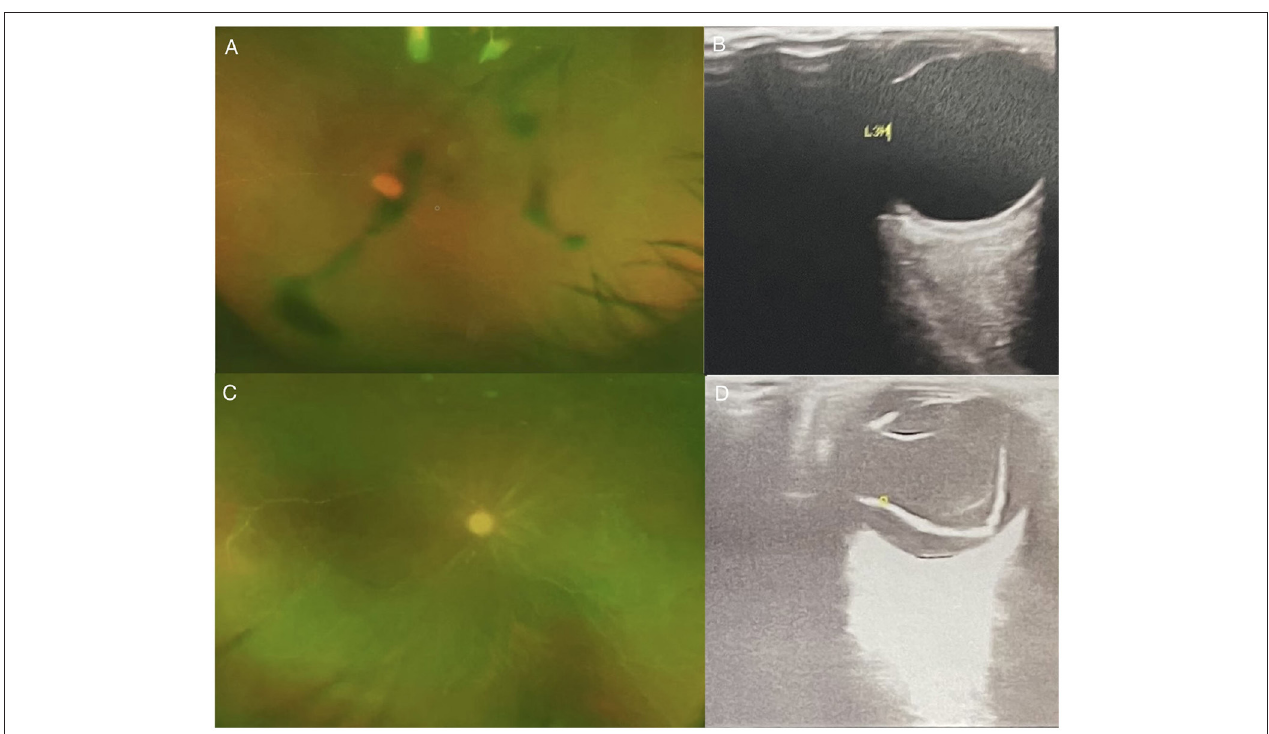
FIGURE 2 | (A) Ophthalmology wide-angle lens examination-L; (B) Ophthalmic Ultrasound-left: The left eye ring is intact, the lens wave is visible, and the dark area of the vitreous body is moderately diffuse. Spot flocculent weak echo and mass echo, and the posterior wall of the ball is slightly thickened. There is no obvious thickening of the four rectus muscles. (C) Ophthalmology wide-angle lens examination-R; (D) Ophthalmic Ultrasound-right: The right eye ring is intact, the lens wave is visible, and low and medium amount of diffuse spot flocculent weak echo and cluster echo are seen in the dark area of the vitreous body. Both the horizontal axis and the vertical axis can be detected in the vitreous “shaped echo” band echo. The tip is connected with the optic papilla, and the two ends are connected with the peripheral spherical